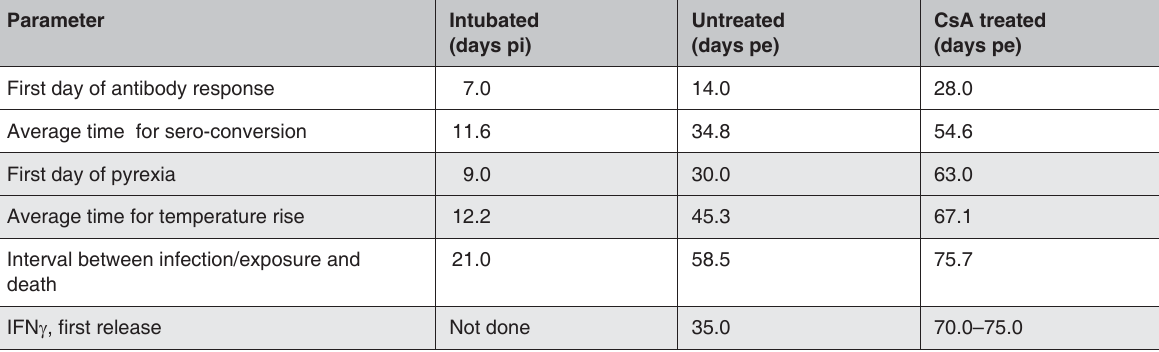
TABLE 5 Summarized average of clinical, pathological and immunological parameters in the three group of